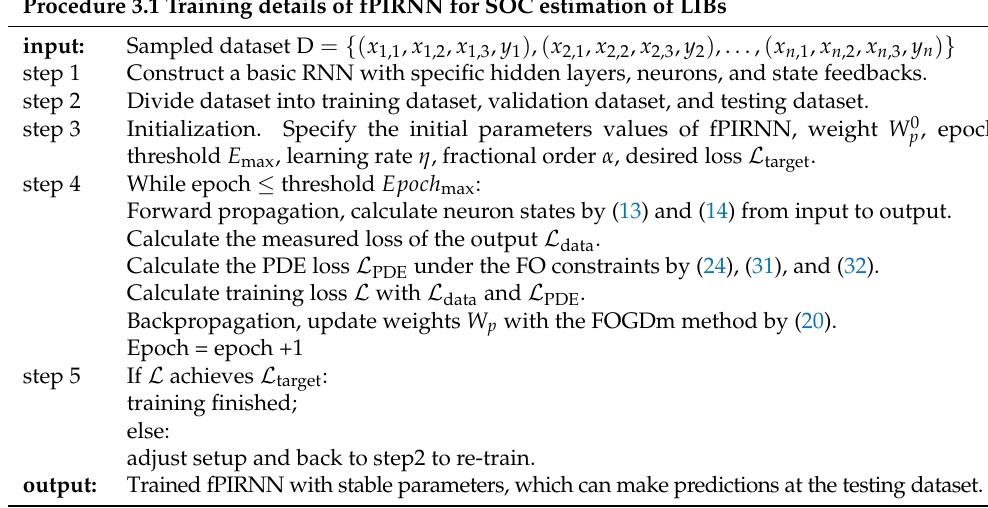
Table 1. Training procedure of the PIRNN with fractional-order constraints. Procedure 3.1 Training details of fPIRNN for SOC estimation of